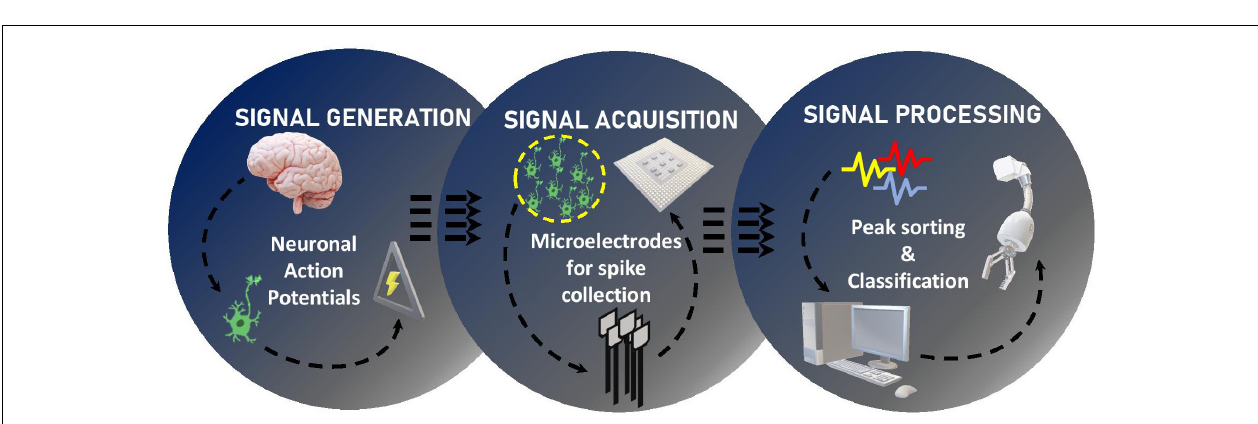
Frontiers in Neuroscience |